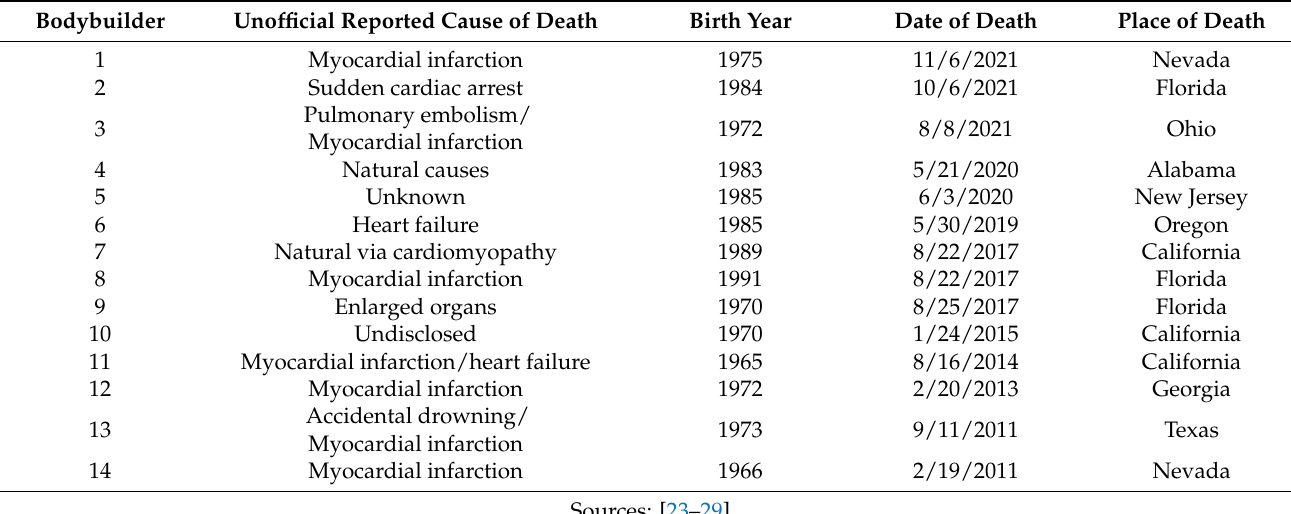
Table 2. Reported deceased bodybuilders (age < 50 years) in the USA from cardiovascular events, natural causes, or unknown causes between 2010–2022.